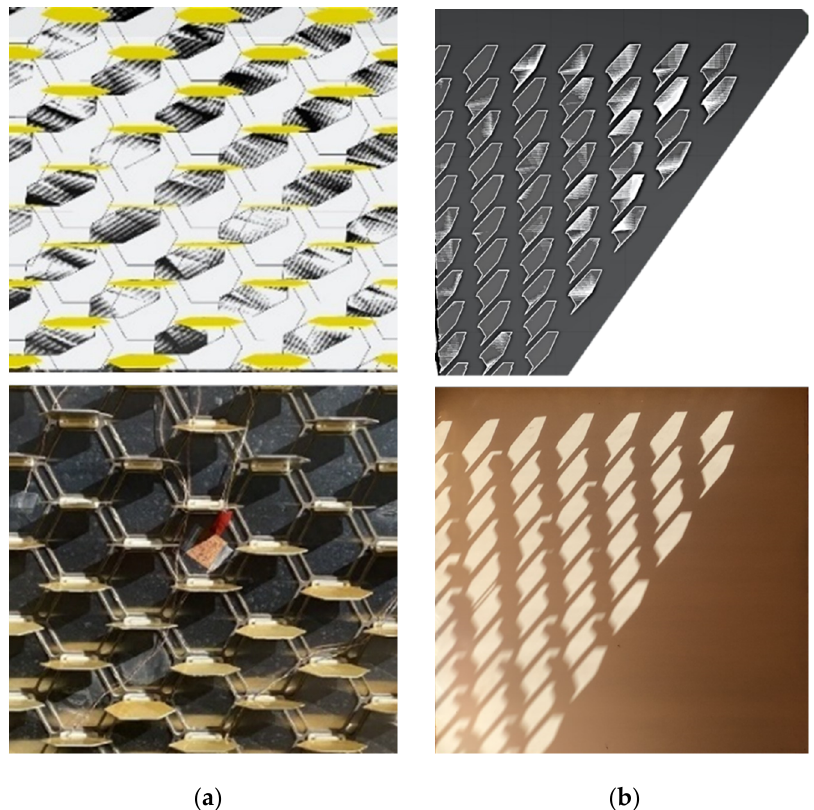
14 of 18 Figure 13. Steps followed during the geometric modeling of the Stegos design implemented in the test box: (from left to right) definitions of parameters, implementation in Rhinoceros Grasshopper, use of embedded models, and evaluation according to various criteria. In the ‘glazing’ configuration, the Stegos acts as a solar shading device and thus as a light-management system. The objective here is to validate the geometrical representation through Rhinoceros Grasshopper. For this purpose, a daylight analysis was performed on a southern-fixed orientation, located in Bordeaux (France), and with dates set as the dates